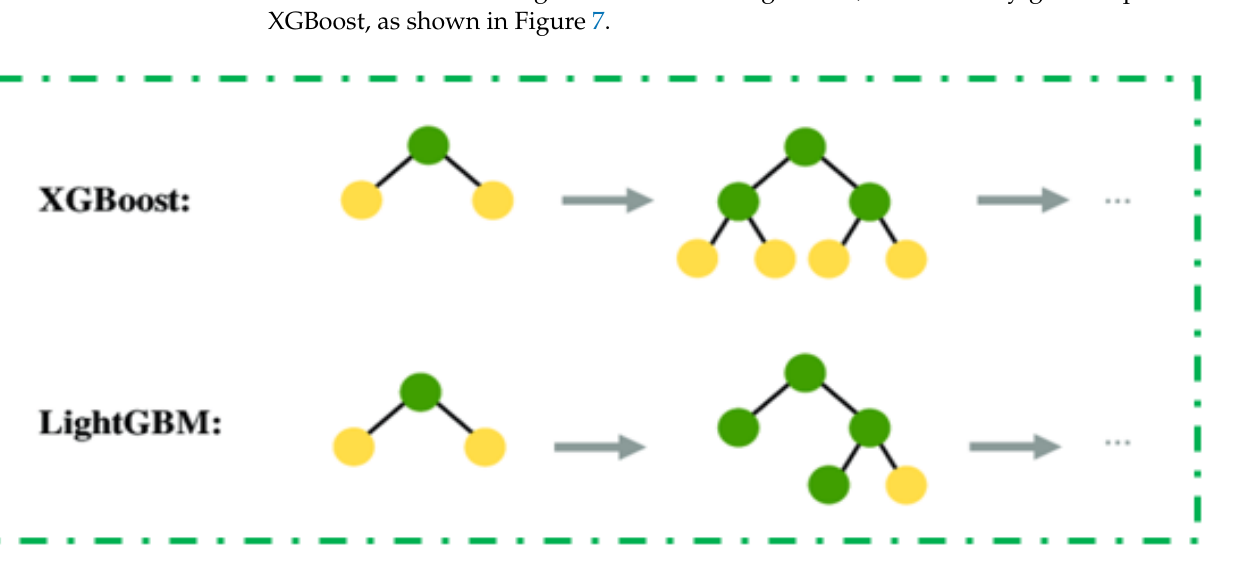
Figure 7. Difference between XGBoost and LightGBM.